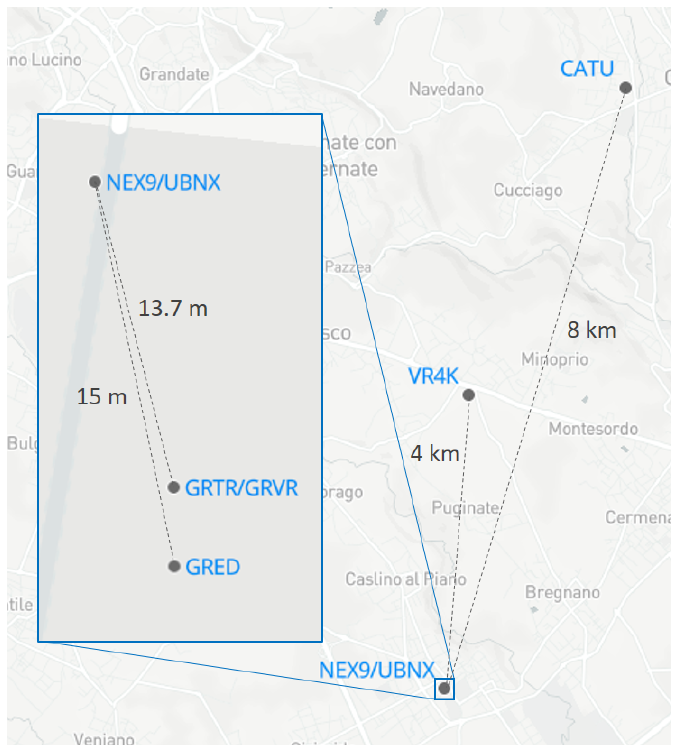
Figure 2. Stations used in the experiment ( c (cid:13) Mapbox, Data ODbL c (cid:13) OpenStreetMap